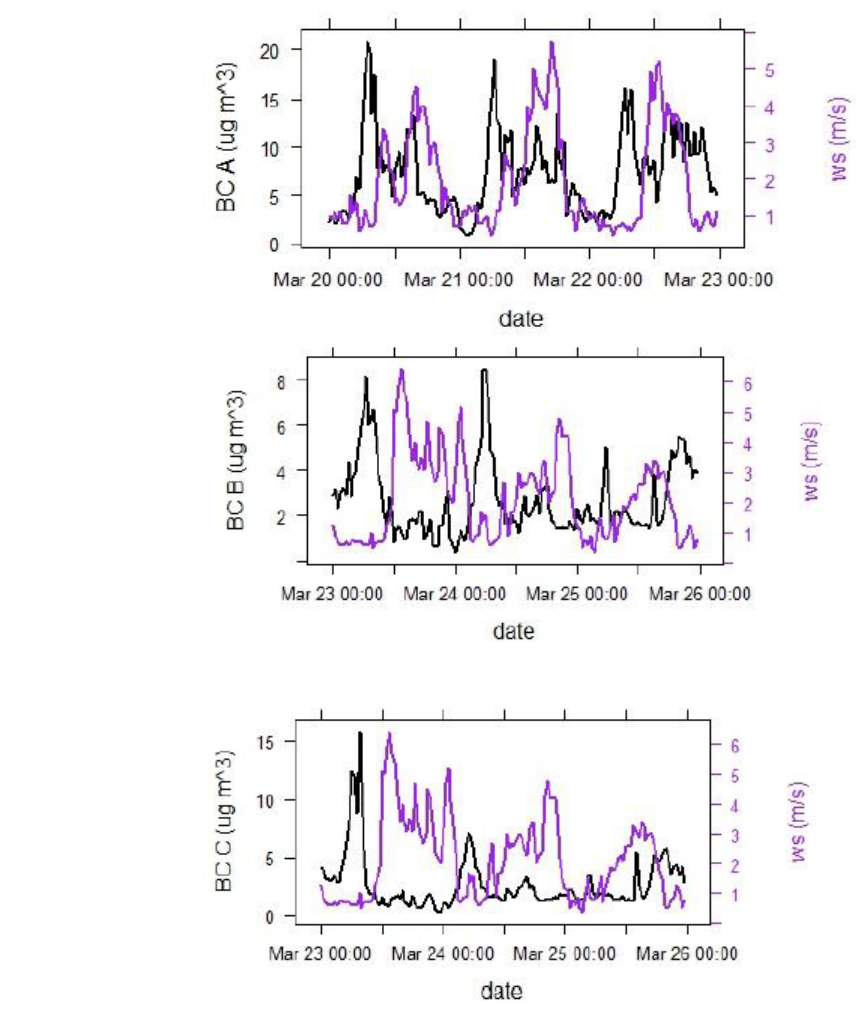
Figure 4. BC concentrations and wind values for measuring point A (graph a ), measuring point B (graph b ), and measuring point C (graph c ). The relationship between BC concentrations and the normalized number of vehicles (NNV) in the winter (graph a) and spring (graph b) at measuring point A are presented in Figure 5.